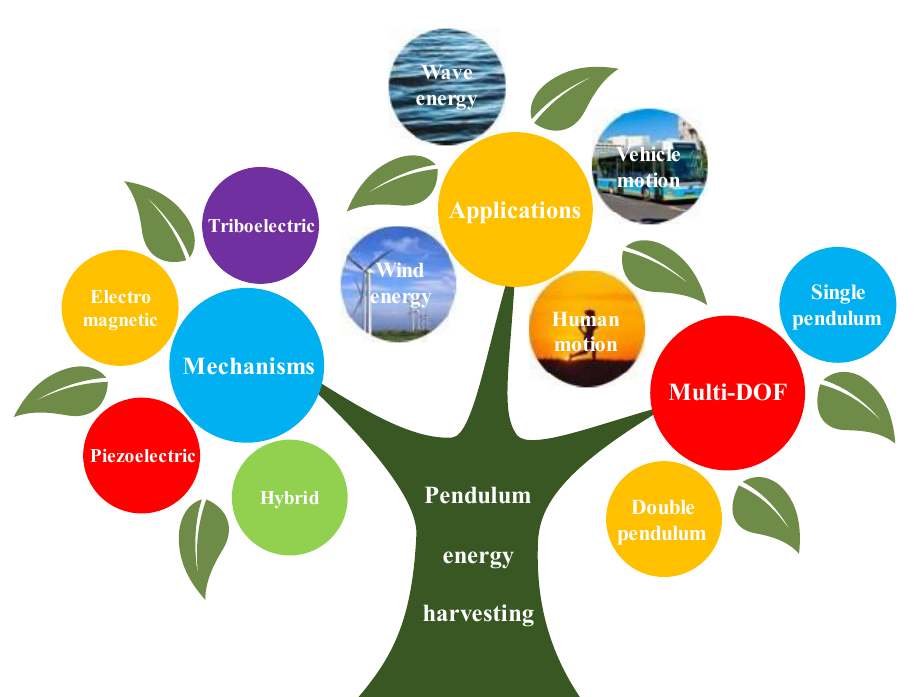
Figure 1. Classification of pendulum energy-harvesting technologies.